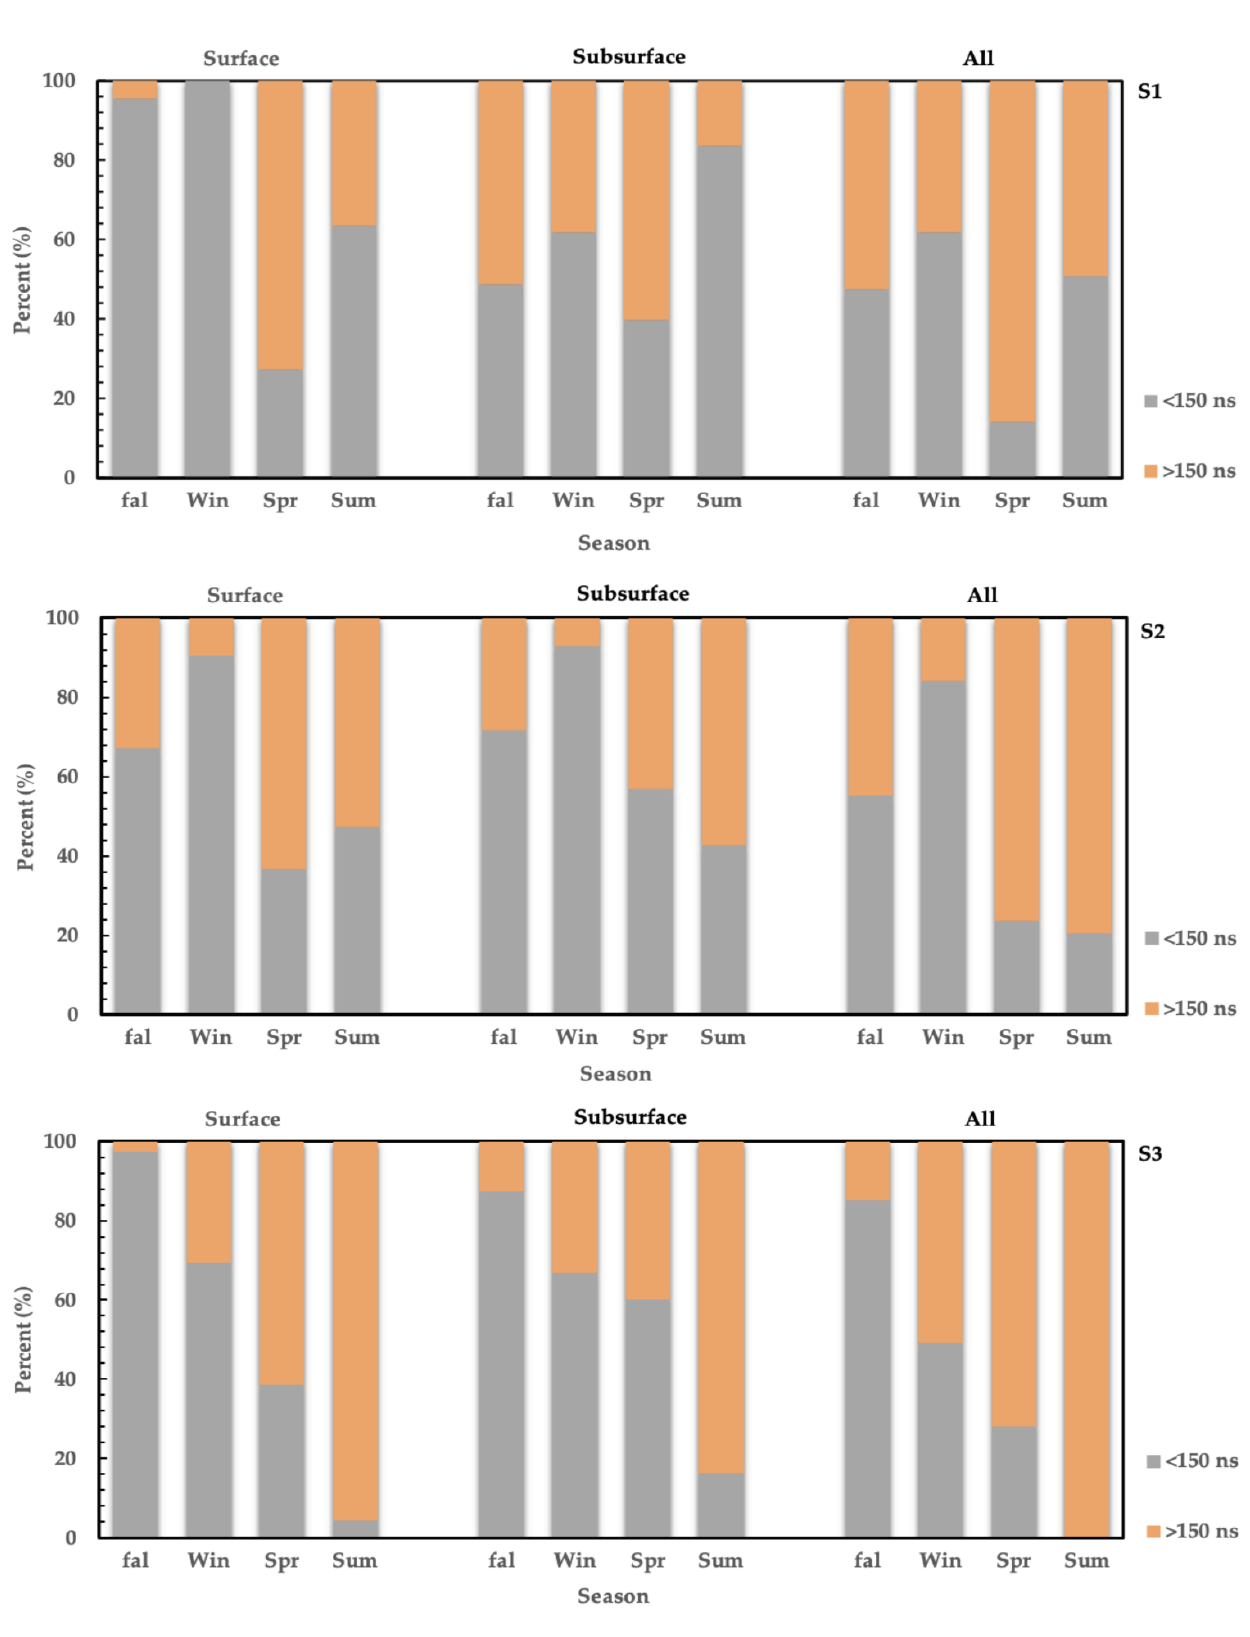
Figure 10. The proportions of echoes with FWHM >150 ns (orange color) and ≤150 ns (grey color) in different seasons in S1 – S3. Data include the surface, subsurface, and all the echoes in the study area. The horizontal axis represents seasons, and the vertical axis shows proportional distribution within each season.